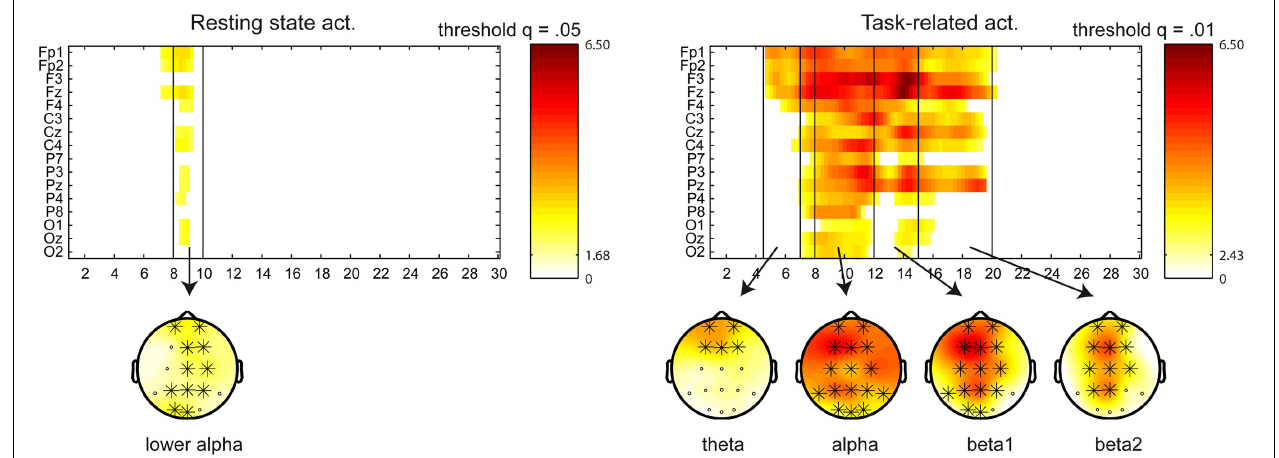
FIGURE 3 | Sensor x frequency maps displaying the significant clusters (in the power spectra) for the NF group in the within-group (pre vs. post) comparison. Left figure displays the resting state activity, and right figure the task-related activity. Significant clusters are shown at a given q threshold. X axis shows the frequency bins in the (1–30Hz) frequency